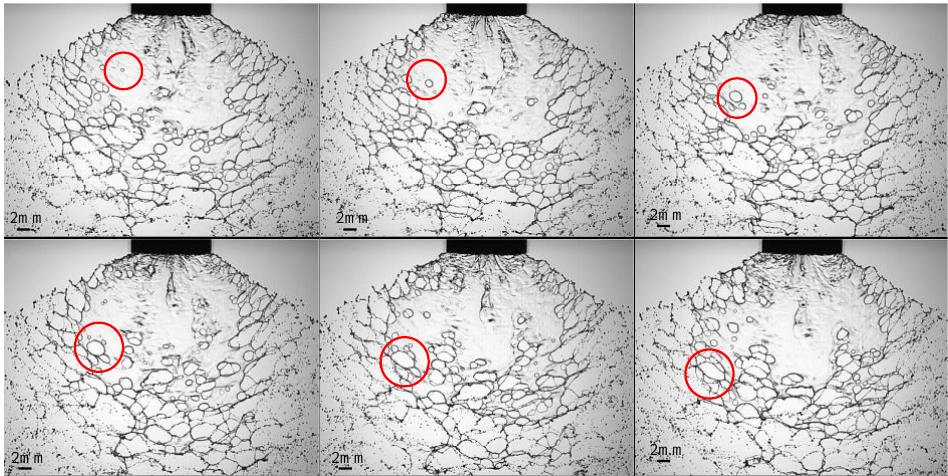
Figure 5. Time scale evolution process of perforation. One hole formation and fragmentation structure is marked by red circles.